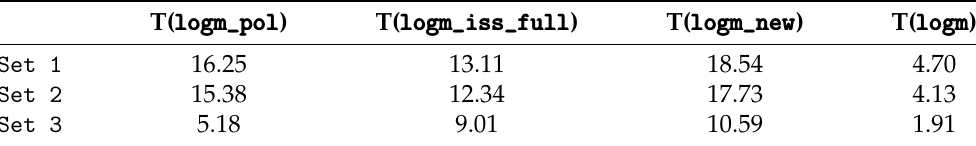
Table 7. Execution time (T), in seconds, corresponding to logm_pol , logm_iss_full , logm_new , and logm for computing matrices in the three